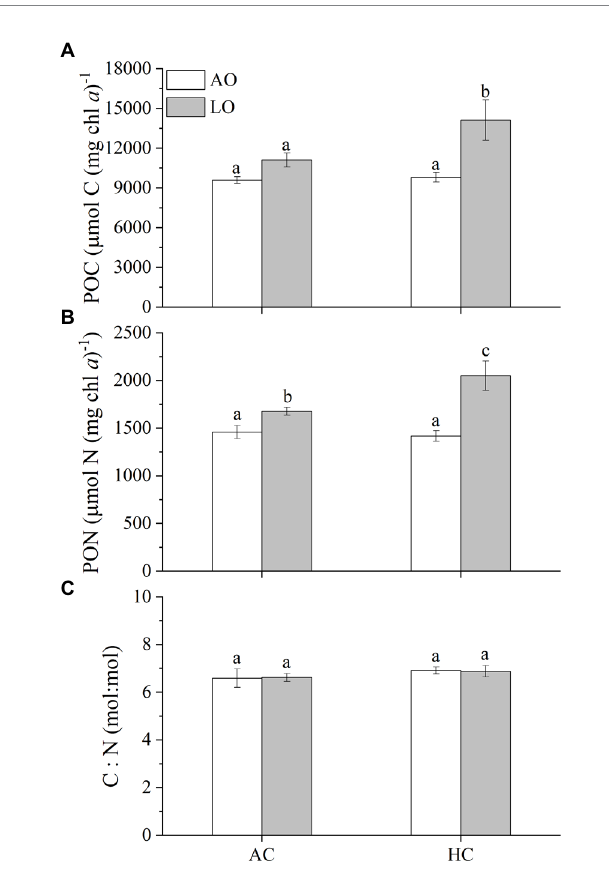
FIGURE 4 The particulate organic carbon (POC) (A) , particulate organic nitrogen (PON) per chl a (B) , and C:N ratio (mol: mol) (C) in T . erythraeum IMS101 grown and acclimated under the different levels of O 2 and CO 2 (see Figure 1) for 36 days (27 generations). The values are indicated as the means ± SD for triplicate cultures at each treatment. Different letters above the bars indicate significant ( p < 0.05) differences among the